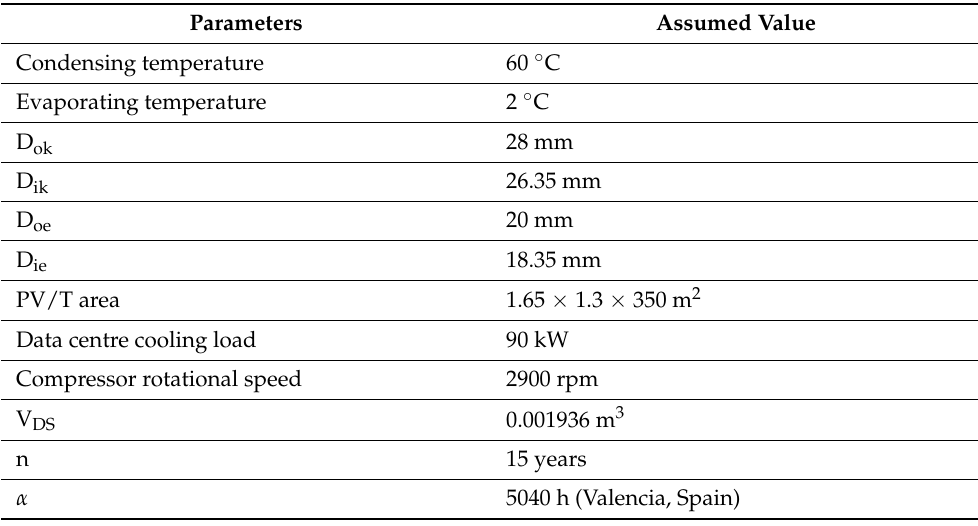
Table 2. Assumptions and boundary